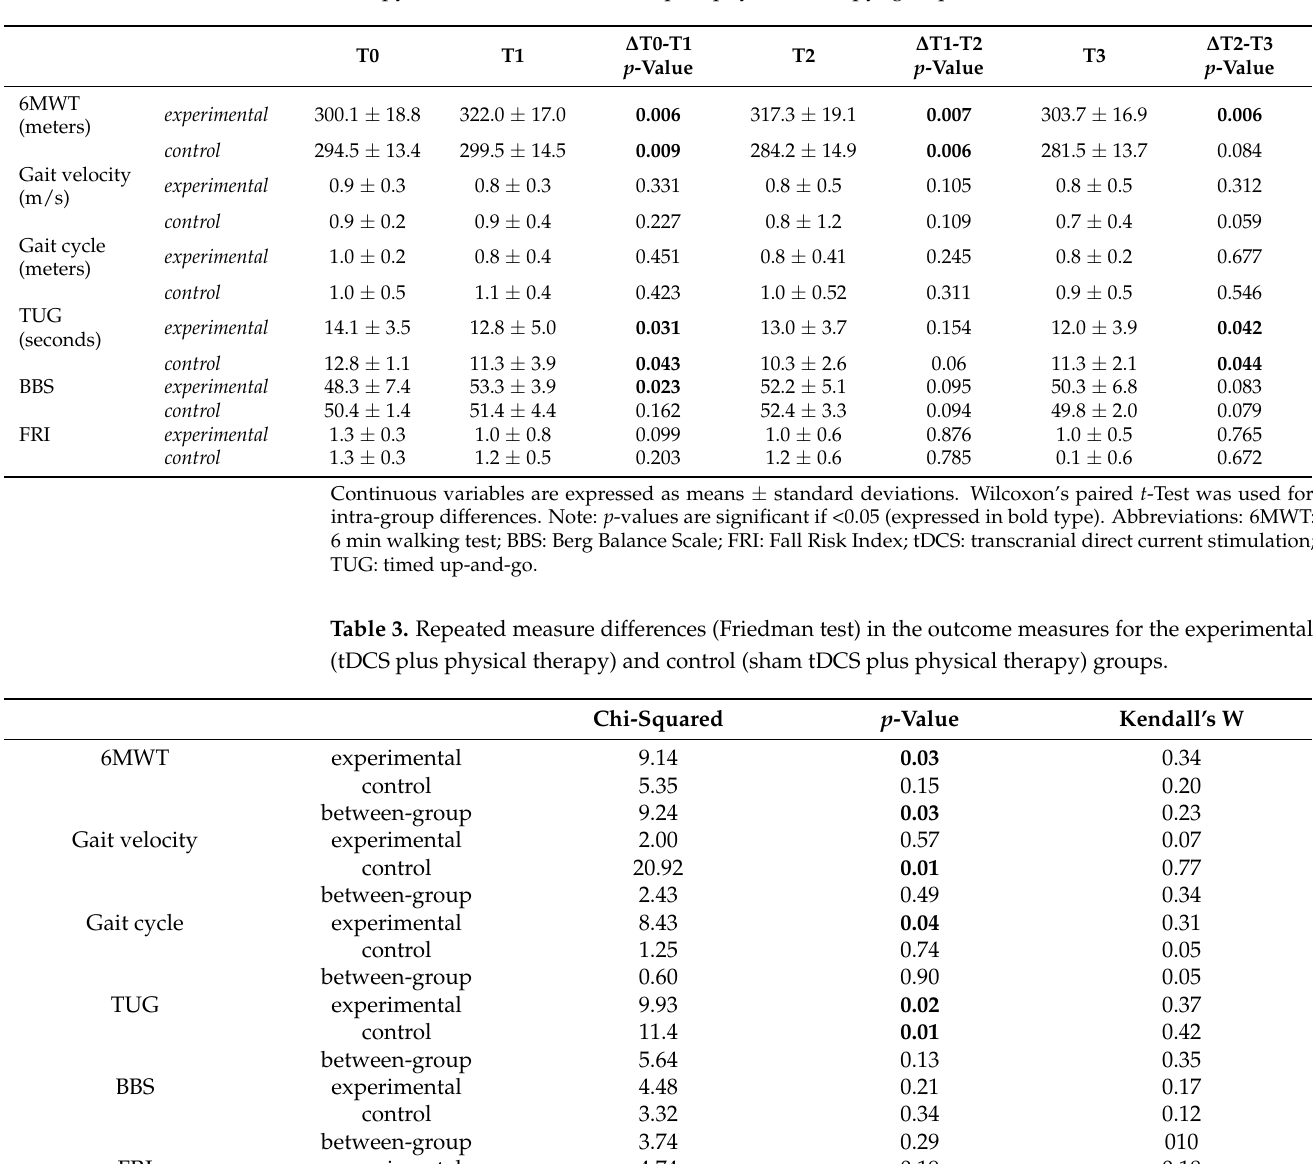
Table 2. Intra-group differences in the outcome measures for experimental (tDCS plus physical therapy) and control (sham tDCS plus physical therapy) groups.